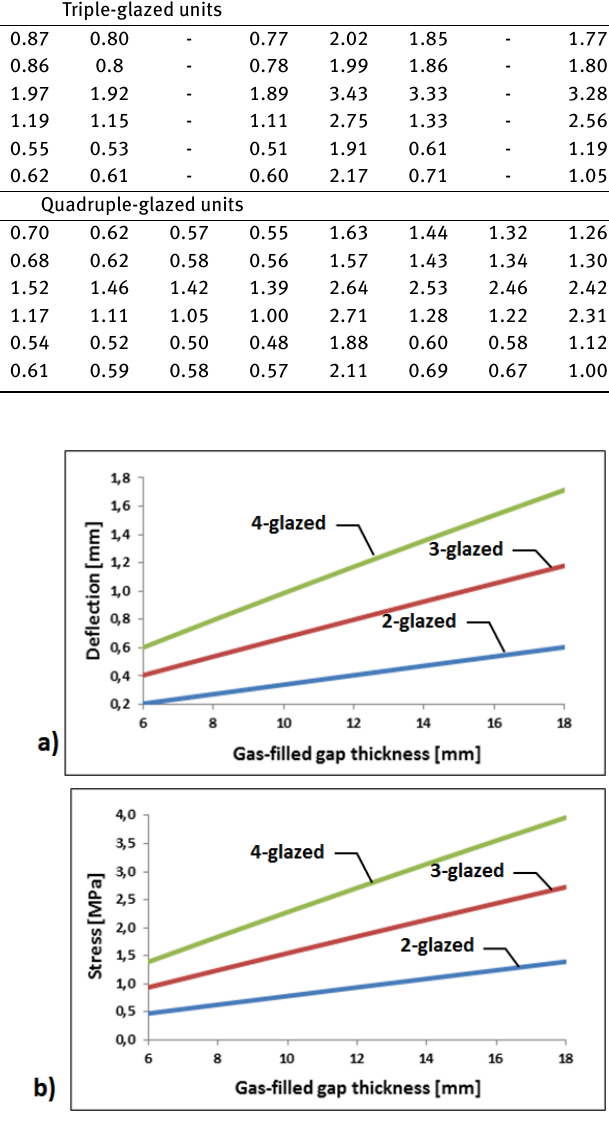
Figure 6: Influence of component glass panes thickness on: a) de- flection, b) stress, in an exemplary unit loaded with increase of atmospheric pressure by 3 kPa.